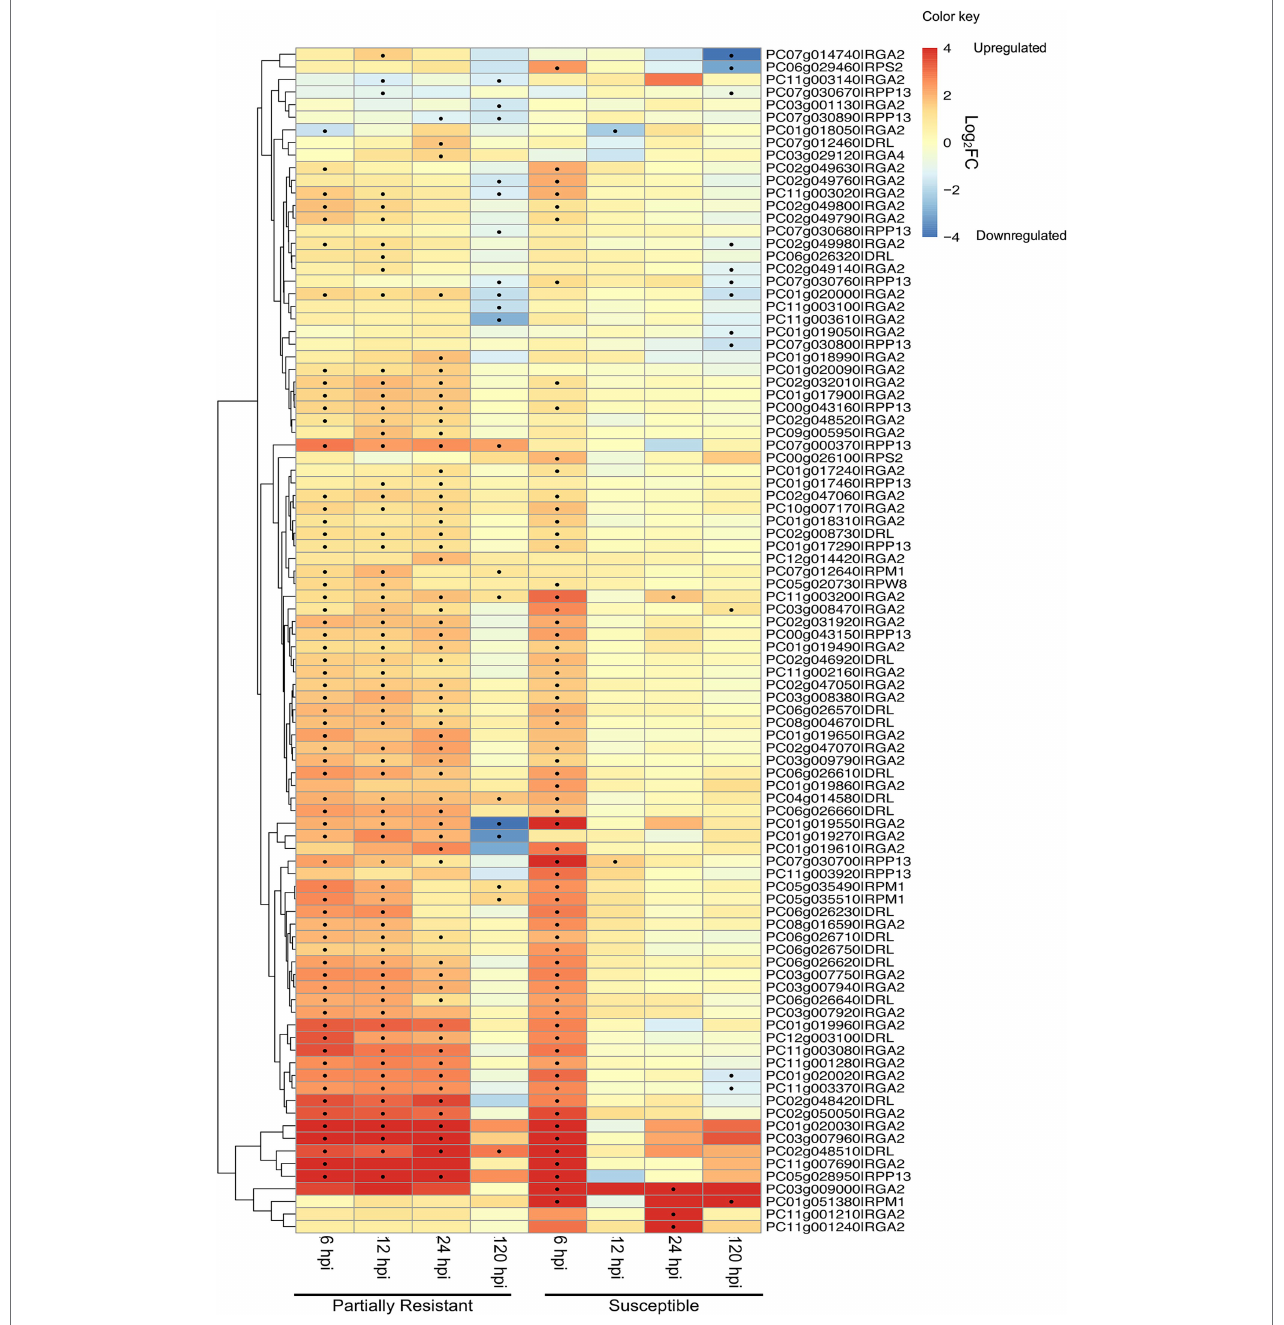
FIGURE 4 | Heatmap and dendrogram showing the expression (as Log 2 Fold Change) of 94 PaNLR genes following Phytophthora cinnamomi inoculation of a partially resistant (Dusa®) and susceptible (R0.12) avocado rootstock. Dots indicate a significant change ( p ≤ 0.05 and |Log 2 FC| ≥ 1) in expression level when compared to mock-inoculated samples (hpi, hours